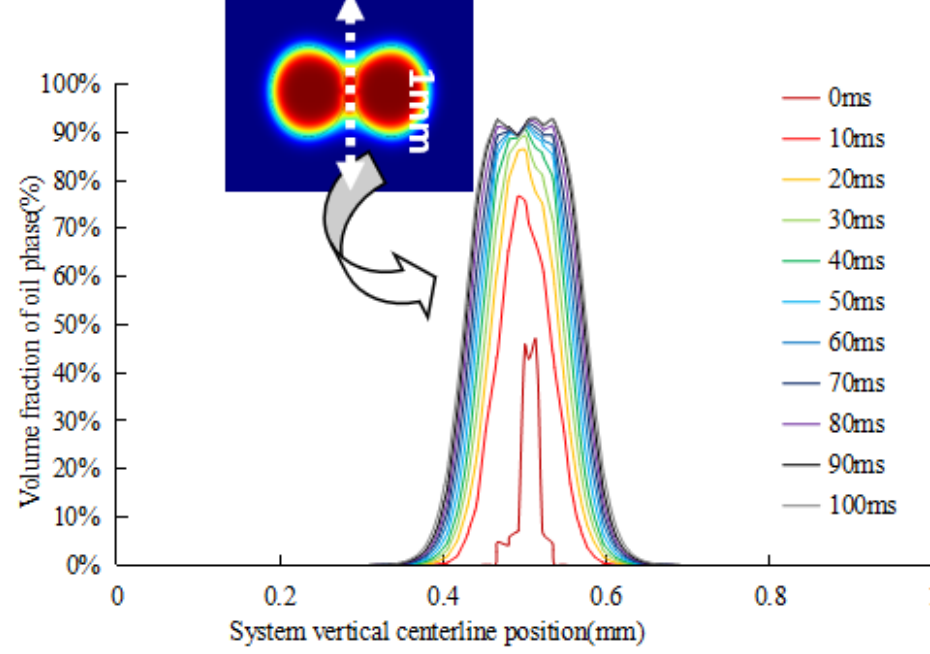
Figure 2. Change in the volume fraction of the oil phase in the system during oil droplet coalescence. Figure 2 shows that the oil phase saturation at the center line of the system gradually increased as the simulation progressed during the coalescence of oil droplet. This indicates that the two oil droplets gradually moved towards each other, and finally formed a large oil droplets. At about 30 ms, the volume fraction of the oil phase reaches about 90%, which was determined to be the initial time for the coalescence of oil